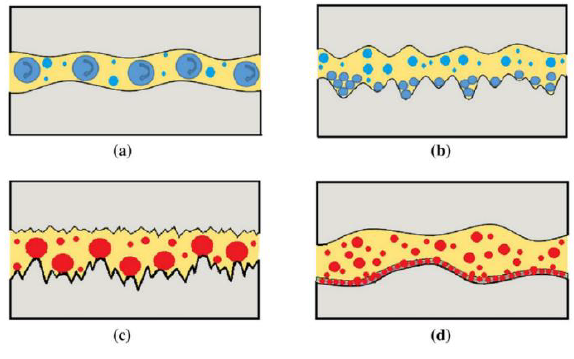
Figure 1. Different working mechanisms for increasing the tribological performance using nanoparticles